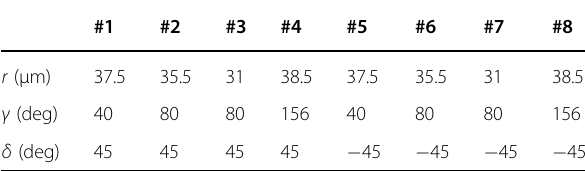
Table 1 Geometric parameters of meta-atoms